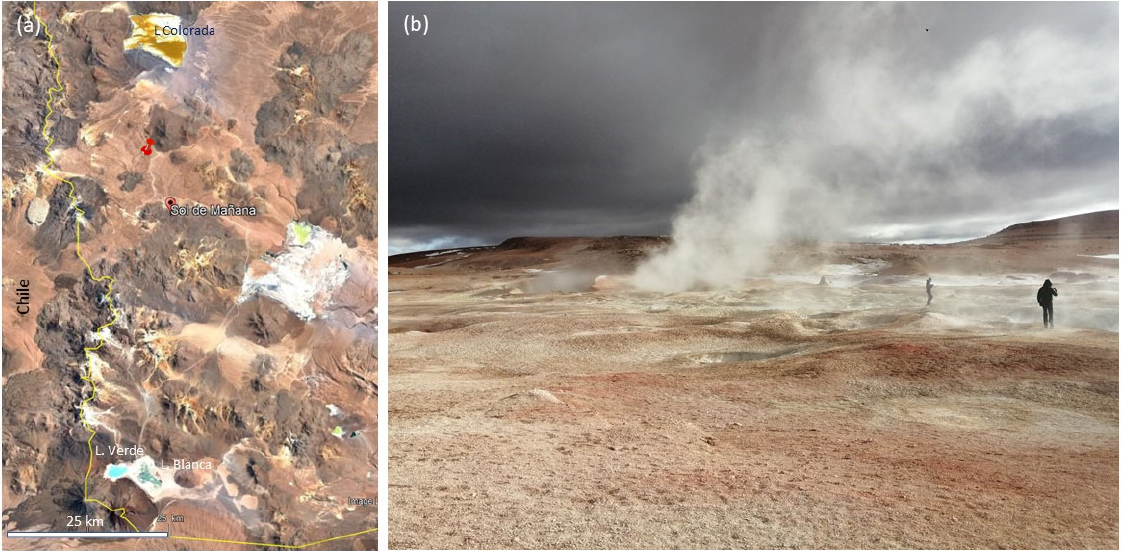
Figure 5. Altiplano Puma volcanic zone: ( a ) satellite view from Laguna Colorada to the Lagunas Blanca y Verde, the yellow line is the border between Chile and Bolivia; ( b ) Sol del Mañana area with its high fumaroles.